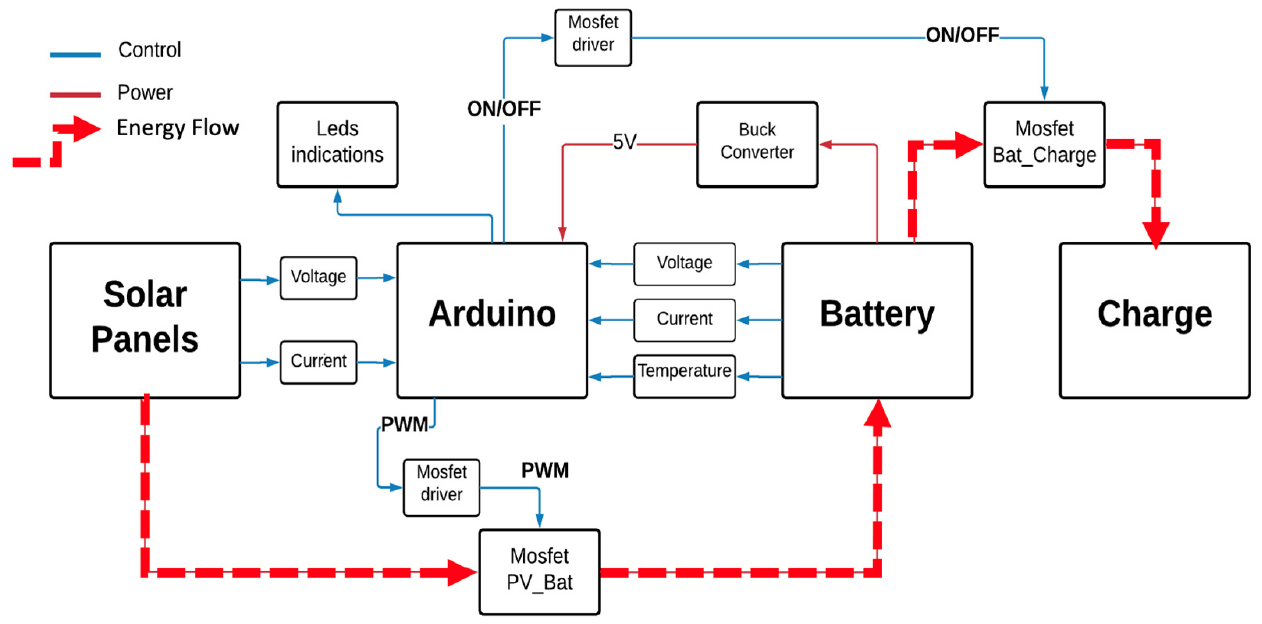
Figure 2. PWM battery charge controller with control/power command connections and energy flow.